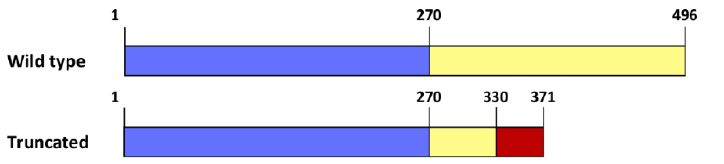
Figure A1. Schematic representation of the wild-type and truncated Gasdermin-E proteins. The necrotic N-terminal domain is represented in blue, and the C-terminal domain in yellow. The aberrant 41-amino acid tail of the truncated protein is represented in red.